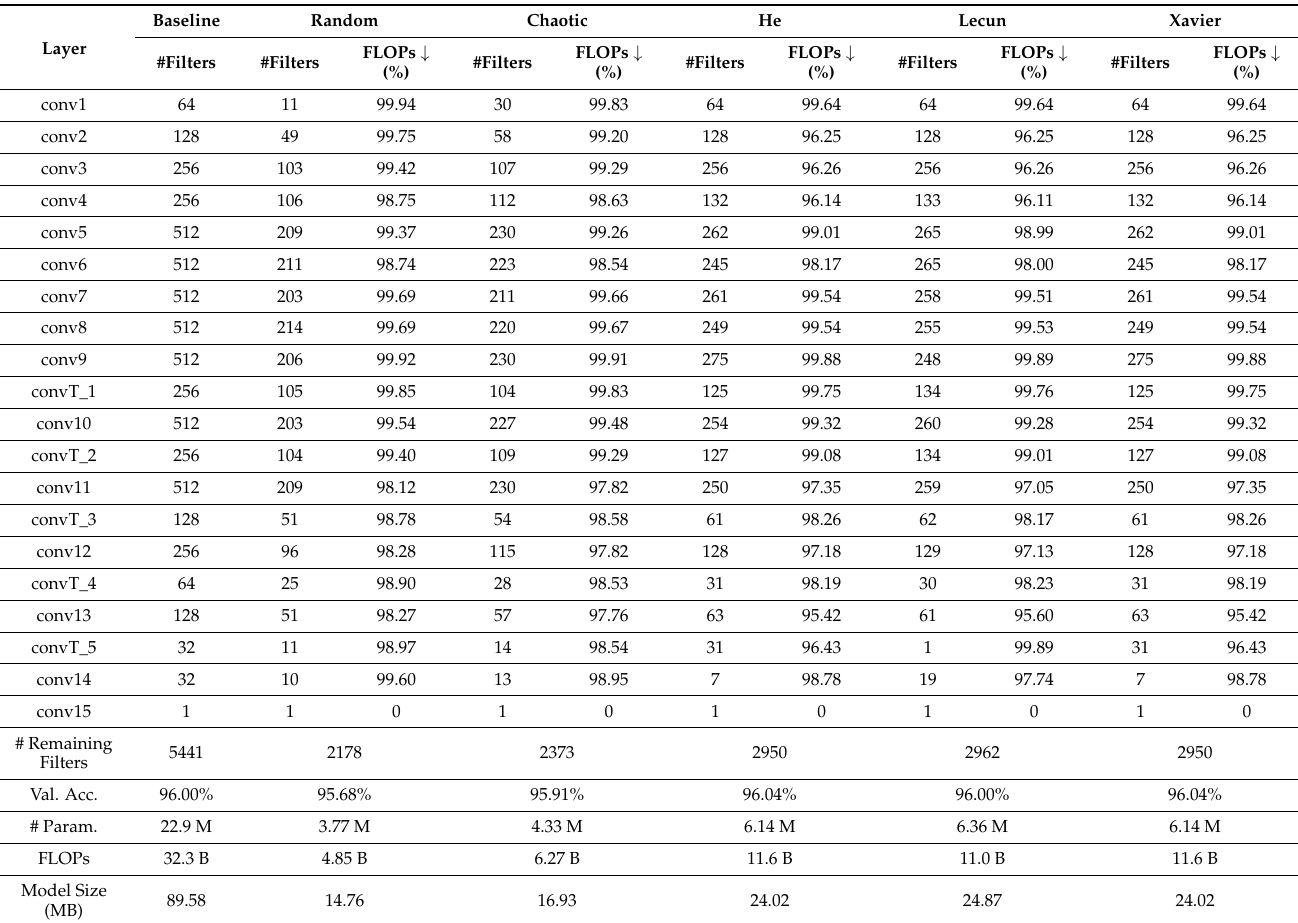
Table 5. Layer by layer pruning statistics for TernausNet on Inria